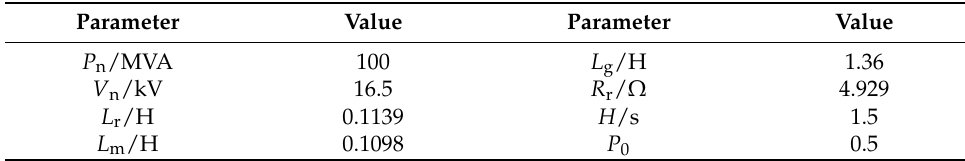
Figure 7. System structure of the grid-connected asynchronous motor. Table 1. Asynchronous motor specific parameters.